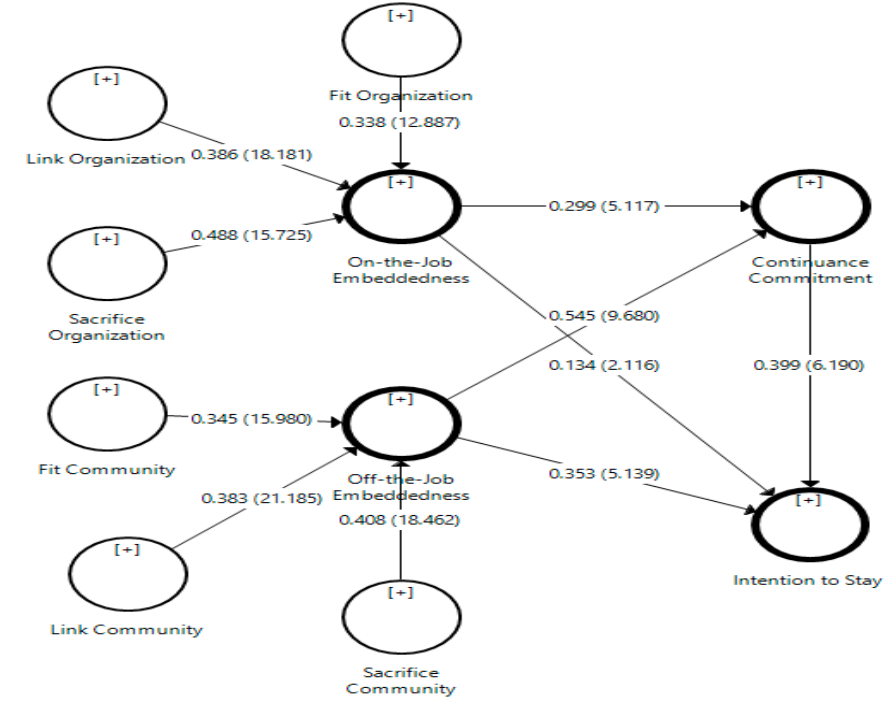
Figure 3. Evaluation of Structural Model through PLS